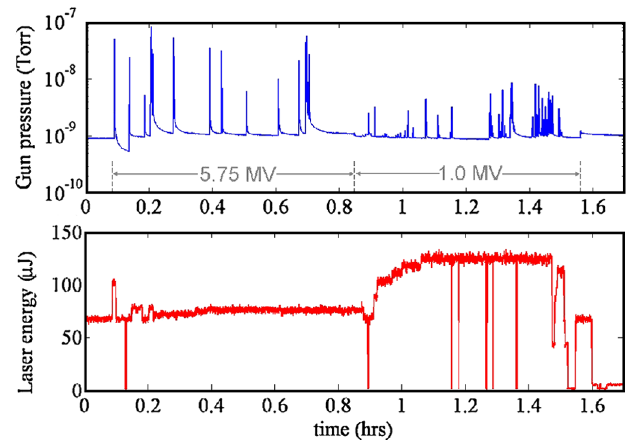
FIG. 15. (Color) The gun vacuum pressure (top-blue) and the laser energy on the cathode (bottom-red) during cleaning of the cathode at 5.75 MV, and later at 1.0 MV of gun rf.